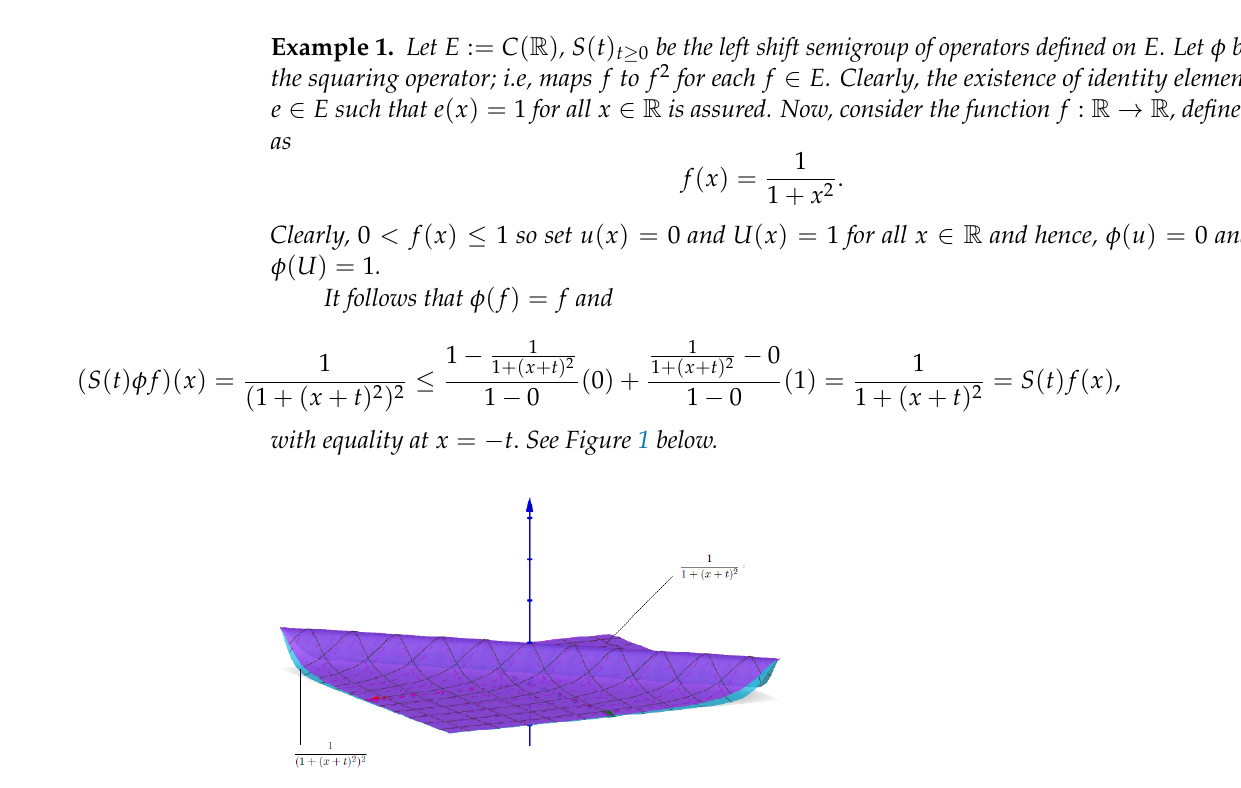
Figure 1. Visualization of converse Jessen’s type